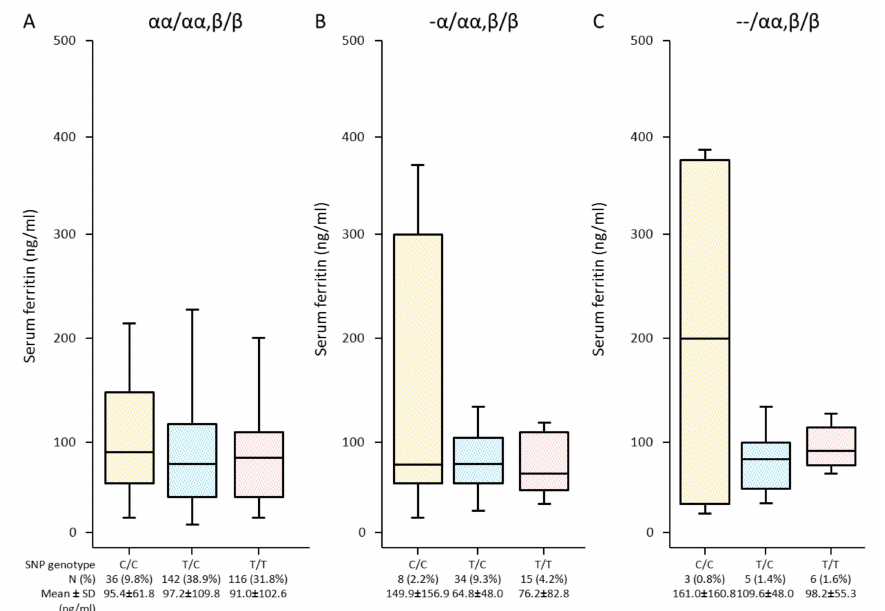
Figure 4. Association of serum ferritin levels with TMPRSS6 SNP rs855791 variation (C/C, T/C, T/T) determined in three studied populations, including normal α -globin genotype ( αα / αα ) ( A ), α + -thal (- α / αα ) ( B ), and α o -thal (–/ αα ) ( C ). (Significant difference at p -value ≤ 0.05 from independent t